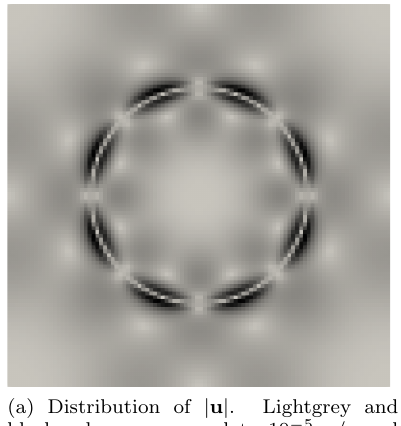
u and u for t = 4 10 6 ∆t = 0 . 19s for scheme C . | | ·